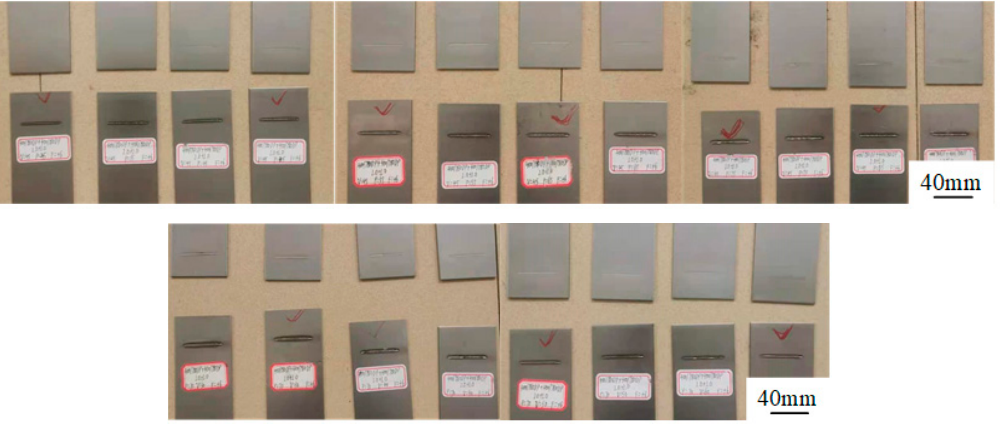
Figure 10. The weld-fracture results under various welding-process parameters. Table 4. The shear strength of WJs with different welding parameters.